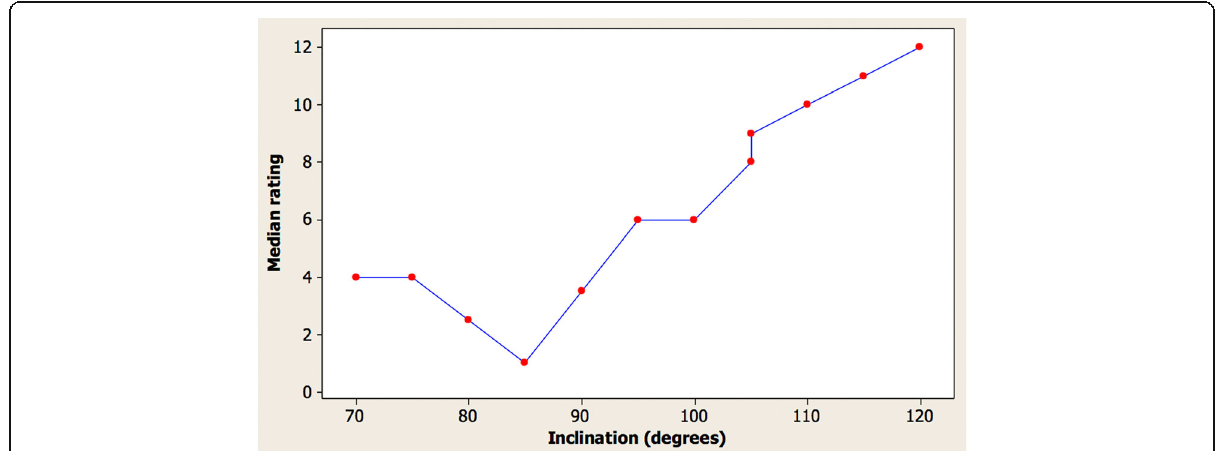
Fig. 5 Median rating by laypeople vs. incisor inclination for female images